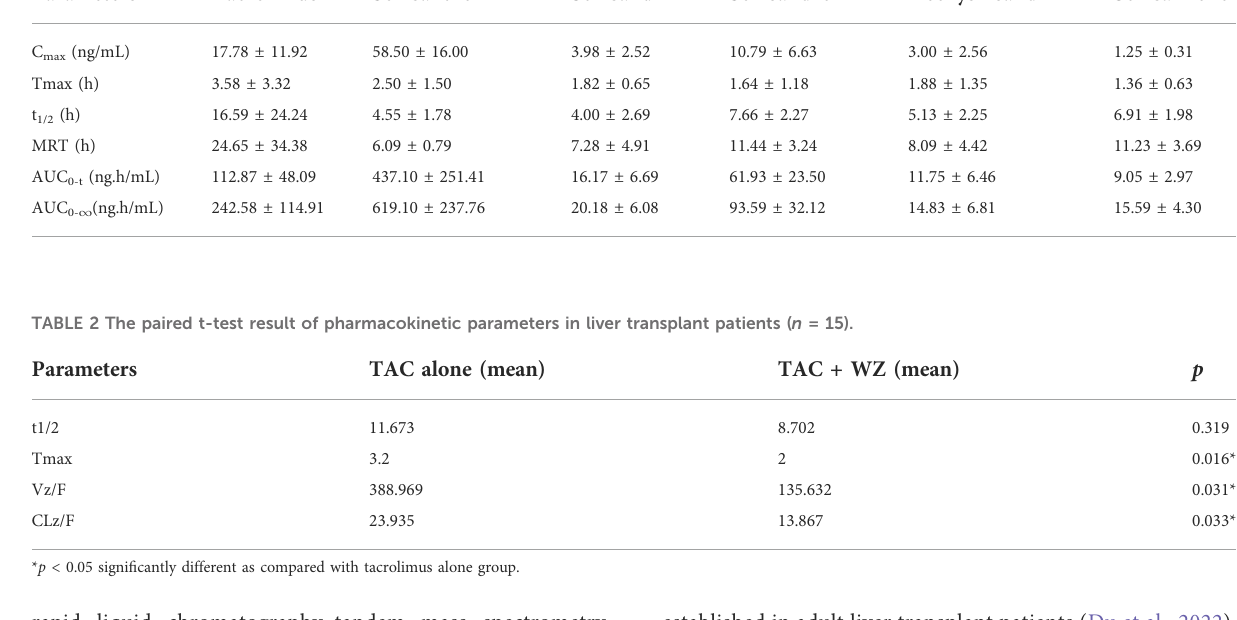
TABLE 1 The mean pharmacokinetic parameters of the analytes in liver transplant recipients ( n = 15). Parameters